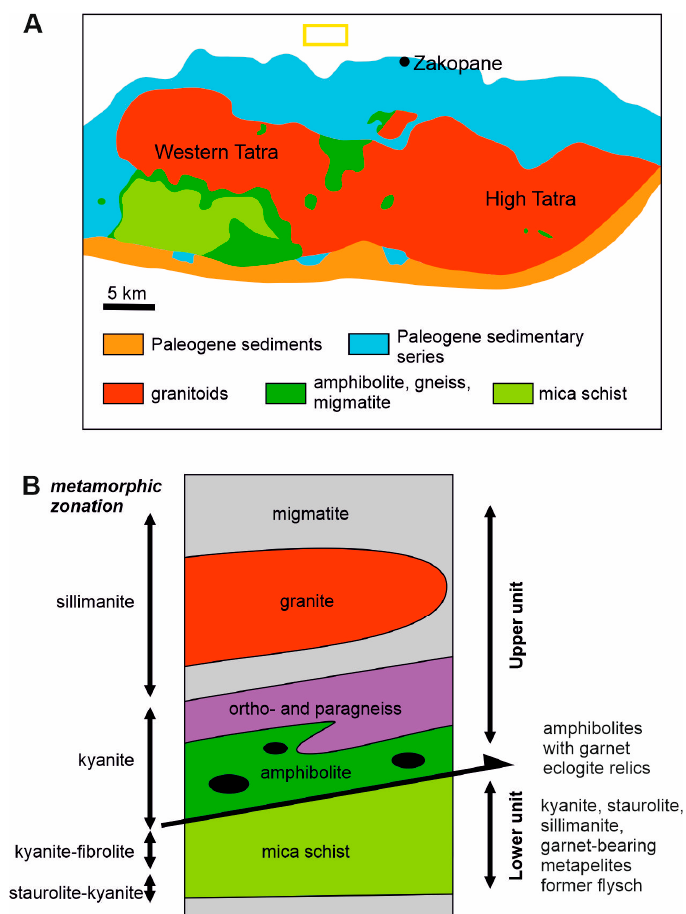
Figure 12. ( A ) schematic geological map of the Tatra Mountains; ( B ) simplified succession along the main tectonic units of the Tatra Mountains with respect to lithology and metamorphic zonation (from Janák et al. [78]). The yellow rectangle indicates the sampling area.